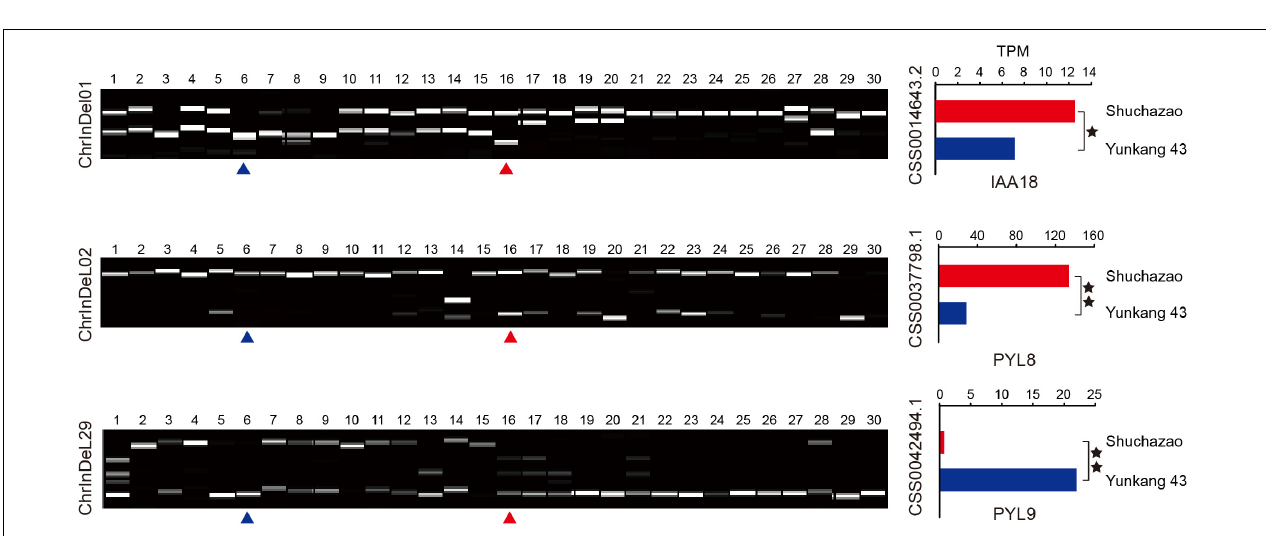
Frontiers in Plant Science |